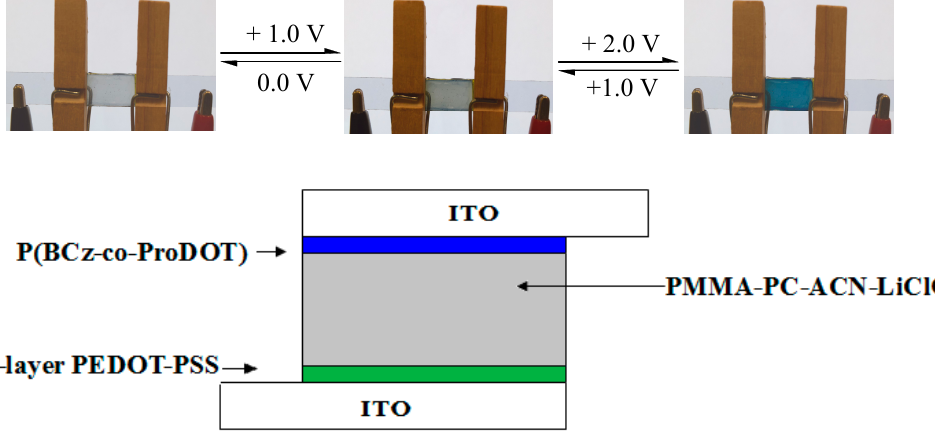
Figure 1. Schematic diagrams of P(BCz- co -ProDOT)/triple-layer PEDOT-PSS device.